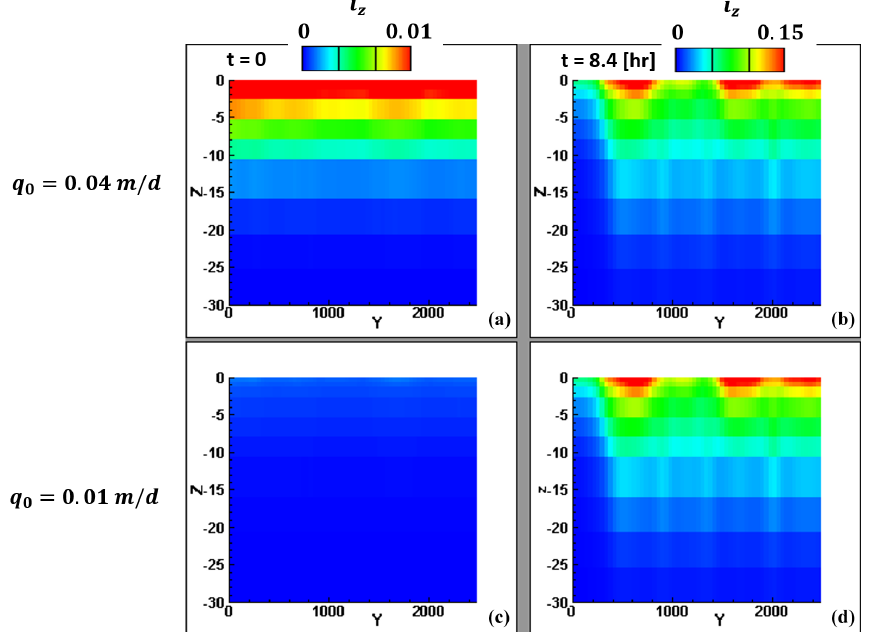
Figure A3. Contours (color scale on the top) of vertical hydraulic gradients ( i z ) at X = 450m (shoreline location) for the pre-surge conditions (left) and the end of the surge when gradients are maximum (right) as a function of vertical Z and alongshore Y coordinates. Note the different color scales between the pre-surge (left) and peak (right) plots.